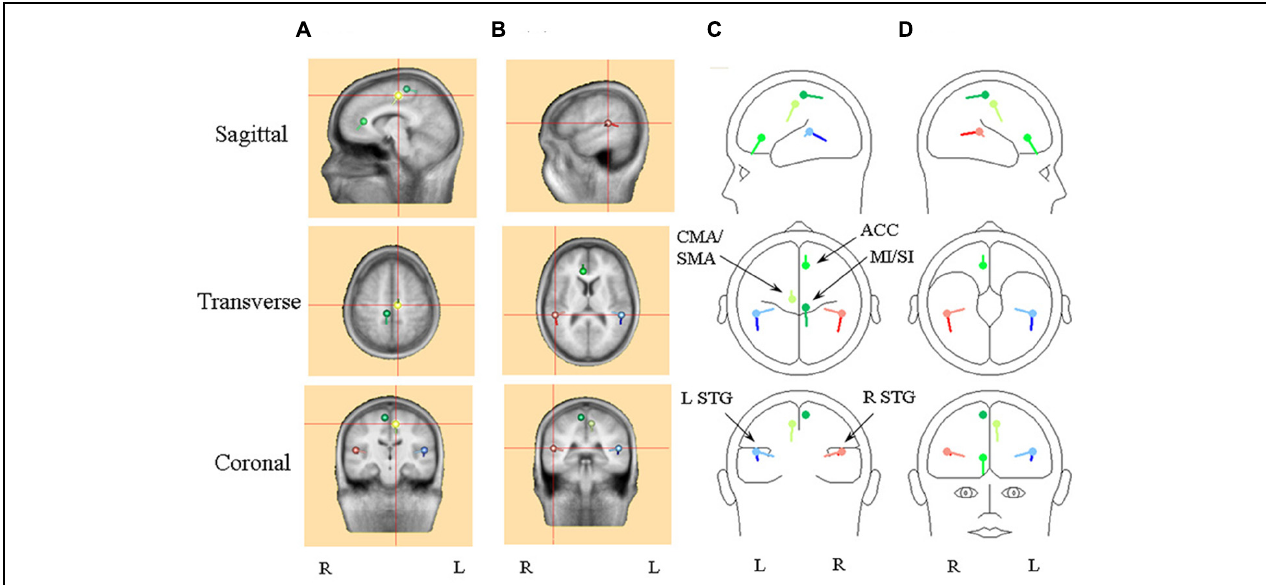
FIGURE 3 | An illustration of the optimum source model selected for detailed comparison, i.e., the model with the pair of regional sources and three dipole. Frontal sources are illustrated with a shade of green, with the cingulate/supplementary motor area (CMA/SMA) source distinguished by light green and the primary sensory-motor cortex source (SI/MI) by dark green. Right hemisphere superior temporal (STG) sources are in red, with the radial source